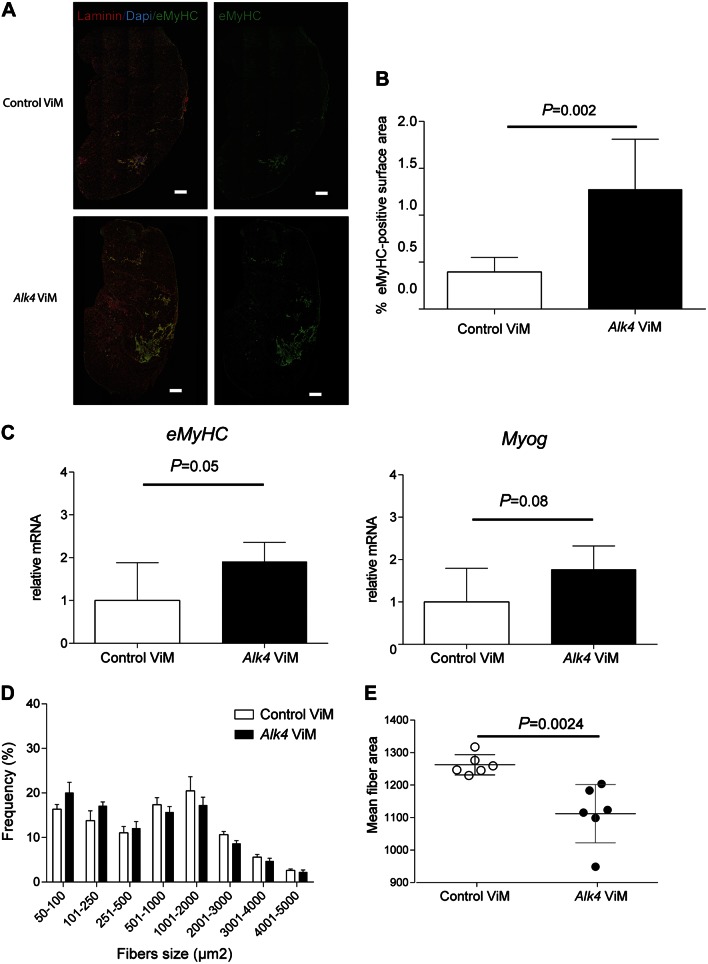
Alk4 down-regulation increases muscle regeneration in mdx gastrocnemius muscles. A) Immunofluorescence images of mdx gastrocnemius muscles treated with Alk4 and control ViM for 7 wk and stained with eMyHC (regenerative fibers, green), laminin (extracellular matrix of muscle fibers, red) and DAPI (nuclear, blue). Scale bars, 100 µm. B) A significant increase in eMyHC-positive area was found in muscles treated with Alk4 ViM. C) Myogenic gene expression measured by qPCR, normalized to Gapdh (n = 6). Up-regulation of myogenic gene expression (Myog and eMyHC) was found after 7 wk of Alk4 ViM intramuscular injections. D) The minimal fiber area was set at 50 µm2 and the maximum fiber area at 10,000 µm2. Between 7 and 10 microscopic views were counted and analyzed, resulting in an average total number of 5000–7500 fibers per muscle. Alk4 ViM-treated muscles showed a significantly higher number of smaller fibers (50-1000 µm2) and a significantly lower number of larger fibers (1001–5000 µm2) than control ViM-treated muscles. E) The mean fiber area was significantly decreased after treatment with Alk4 ViM in muscles. Error bars, sd.